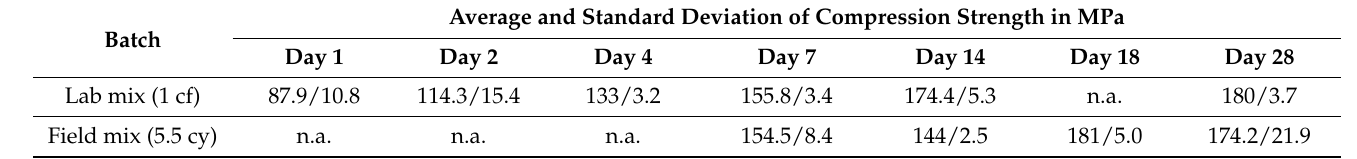
Table 2. Compressive strength and standard deviation results of lab and field mix specimens. Average and Standard Deviation of Compression Strength in Batch